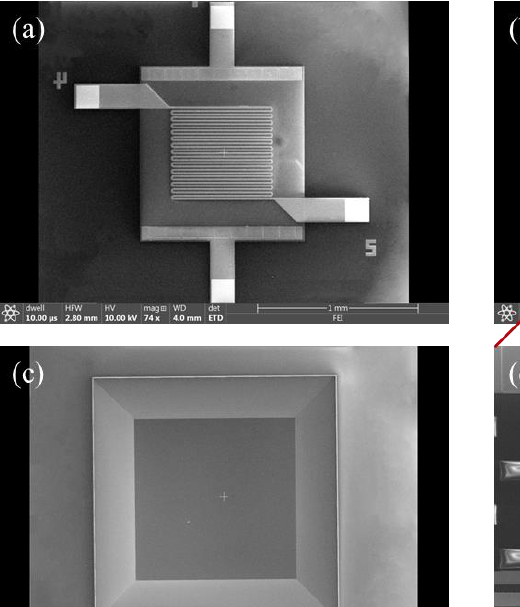
Figure 1. Poly-Si microhotplate fabrication process flow.